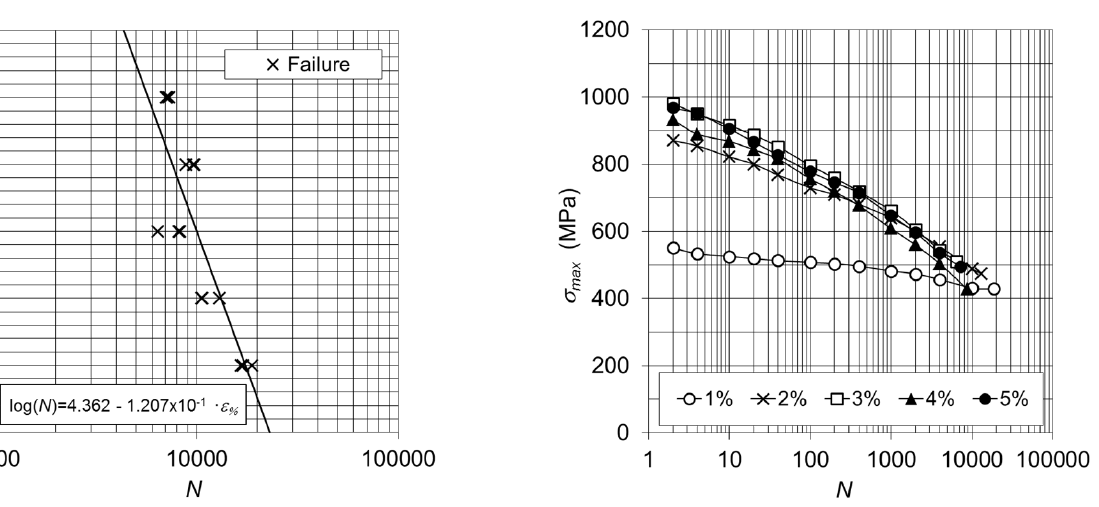
Figure 4: Woehler’s diagram with the fatigue results for the constant-strain tests.